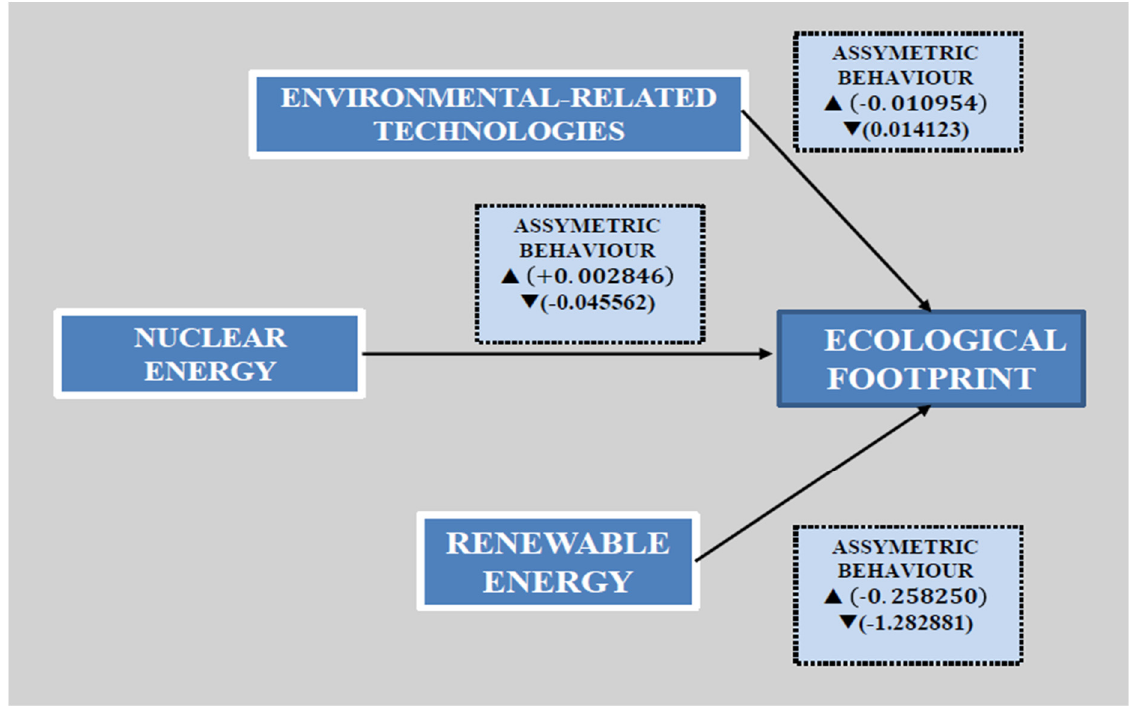
Figure 3. Graphical presentation of empirical findings.